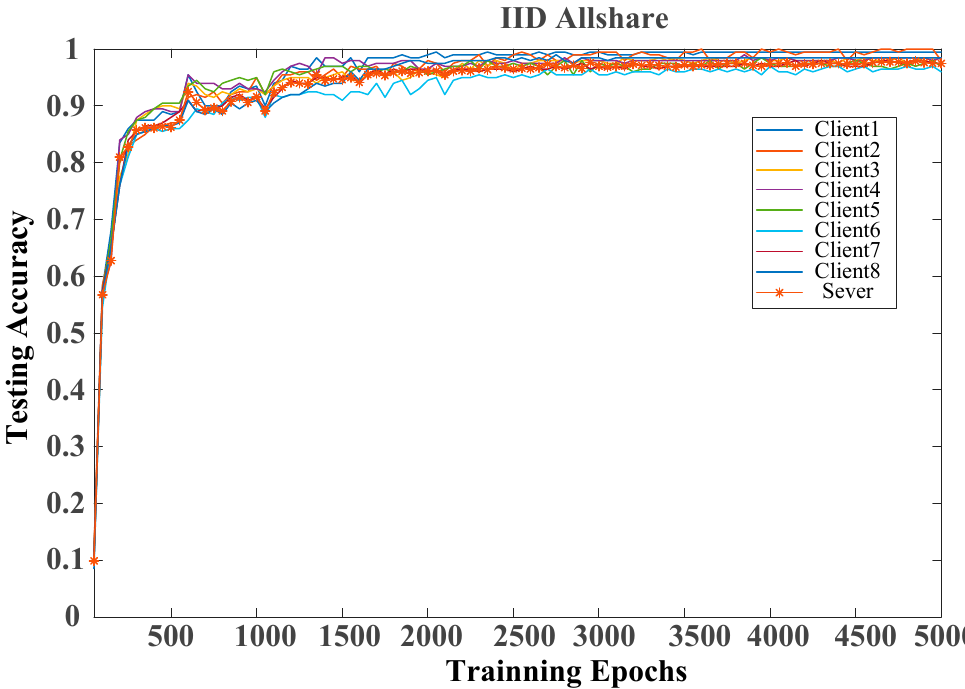
Figure 11. Accuracy rates trend under IID data distribution with network parameters isolated.